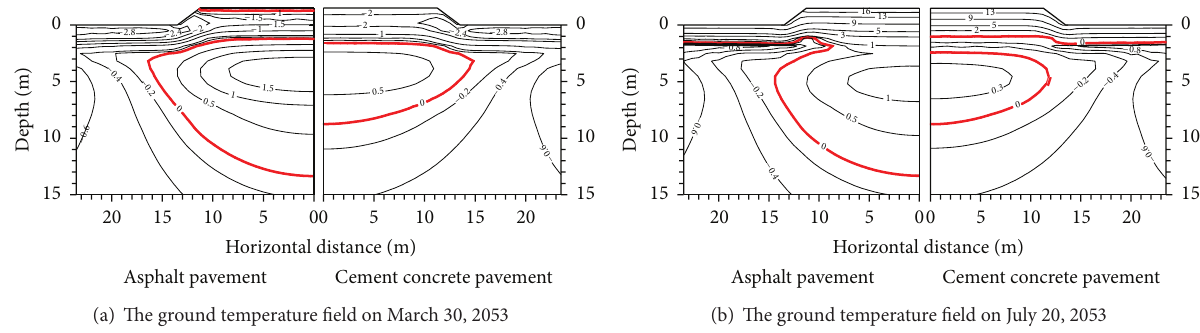
Figure 10: Temperature values of the 50th year under concrete pavement and asphalt pavement (width of